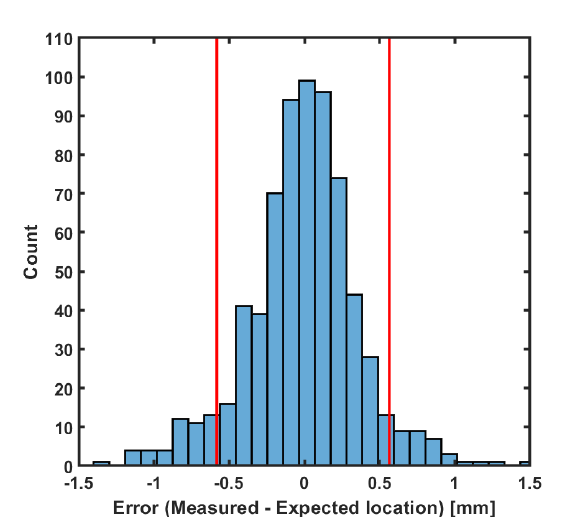
Figure 11. Position error of all tracked fragments. Red lines indicate the tolerance